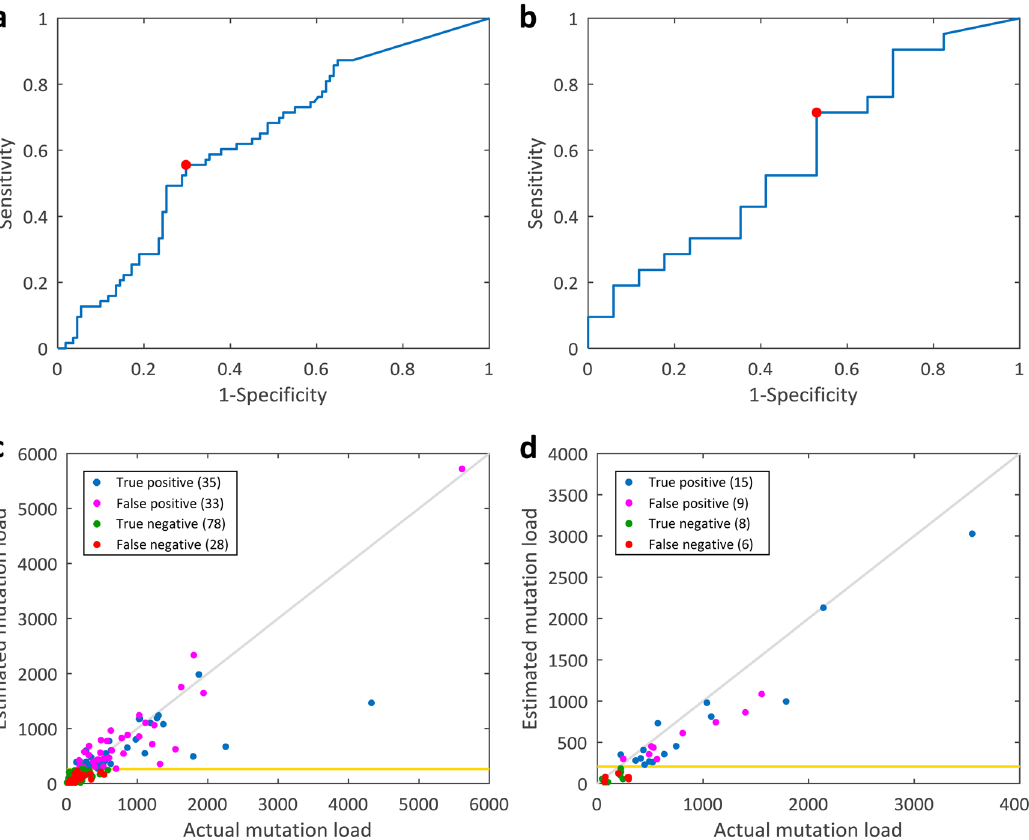
Fig. 5 Performance evaluation of the immunotherapy treatment response prediction using the melanoma mutation load estimation model. a ROC curve for the classi fi cation of clinical bene fi ts using the estimated mutation load in the anti-CTLA-4 treatment patients. Red point, the optimal discrimination threshold 264. AUC = 0.6270. b ROC curve for the anti-PD-1 treatment patients. Red point, the optimal discrimination threshold 206. AUC = 0.5812. c Immunotherapy response prediction using the estimated mutation load for the anti-CTLA-4 treatment patients. Gold horizontal line represents the optimal discrimination threshold 264. The accuracy of the classi fi cation is 0.6494. d Immunotherapy response prediction for the anti-PD-1 treatment patients. Gold horizontal line represents the optimal discrimination threshold 206. The accuracy of the classi fi cation is